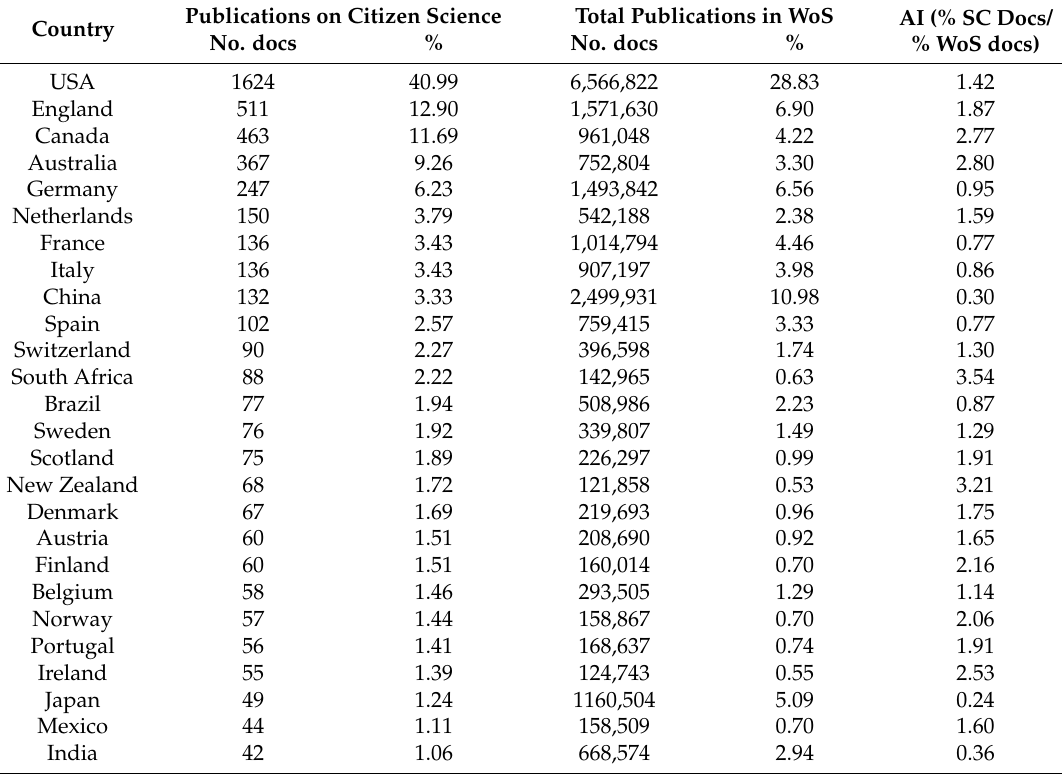
Table 2. Output by